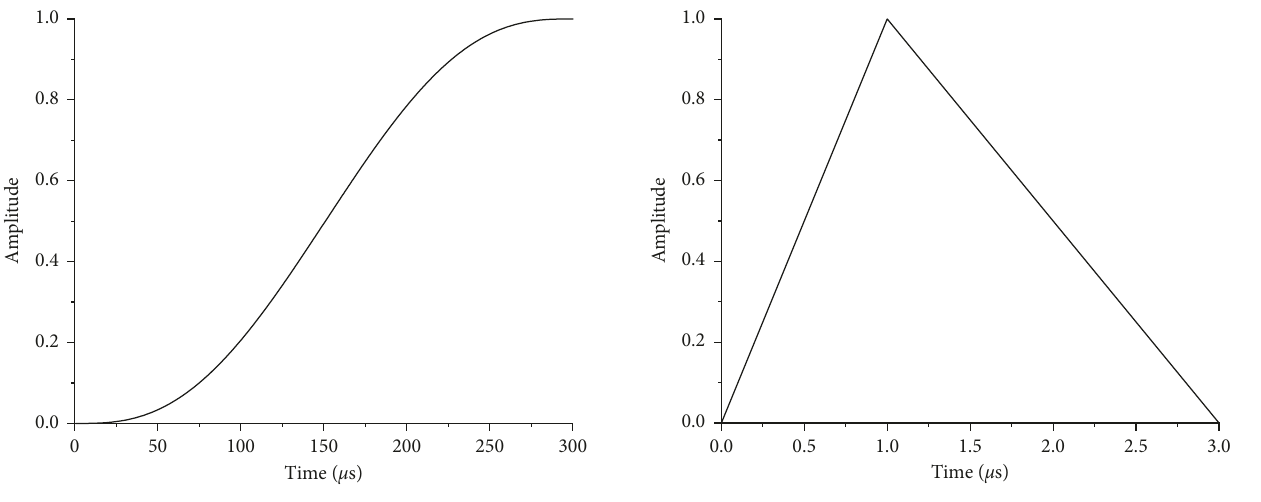
Figure 3: Tension load curve of tension. Figure 4: Excitation